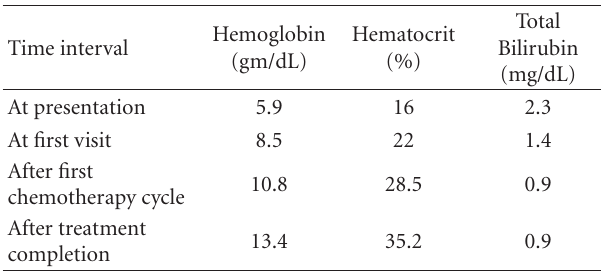
Table 1: Hemoglobin/hematocrit, and bilirubin values at presenta- tion and during